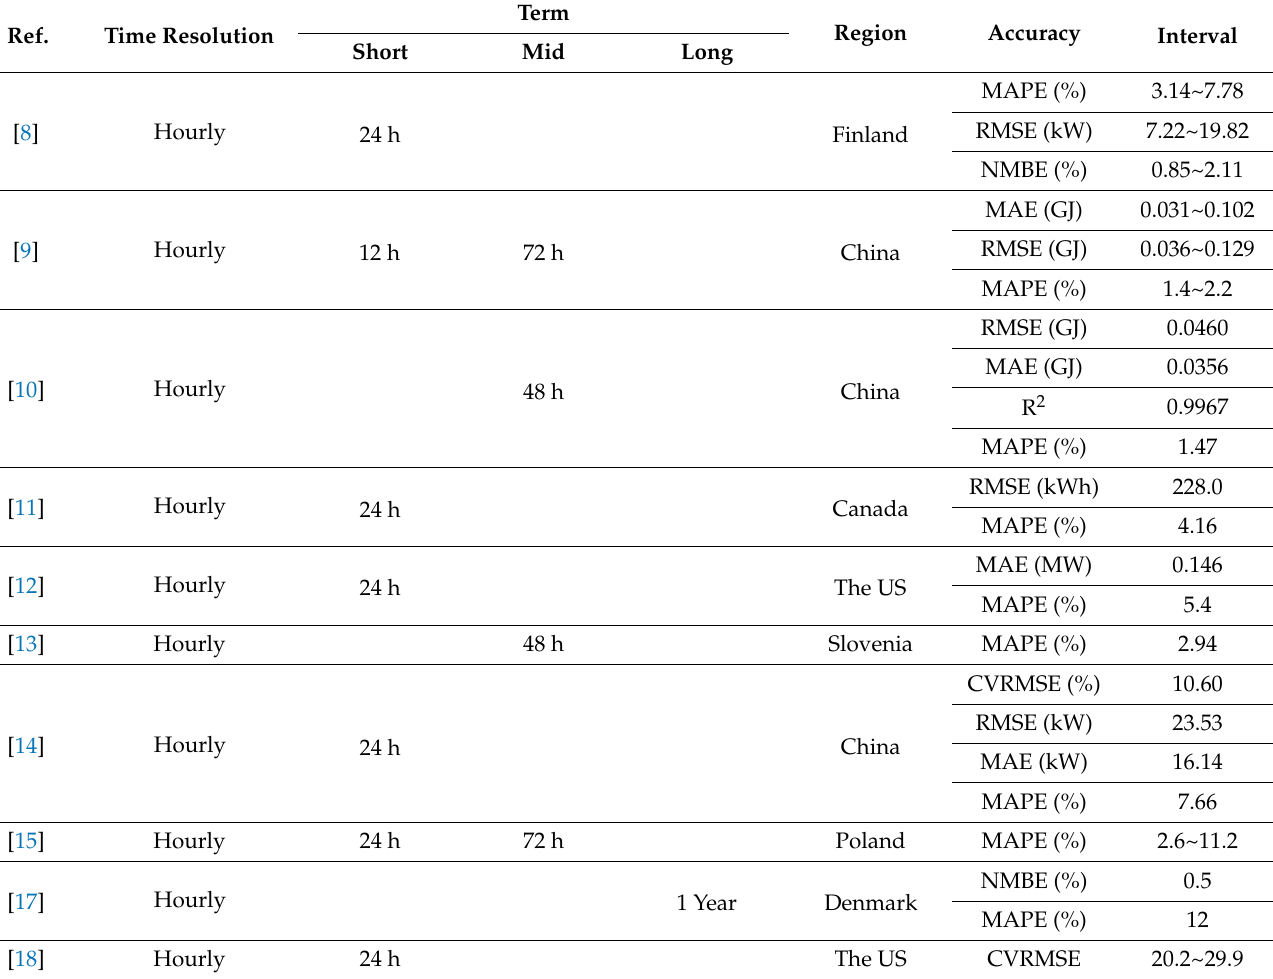
Table 1. Key features of 10 prominent studies on heat forecasting from 2019 to 2021.